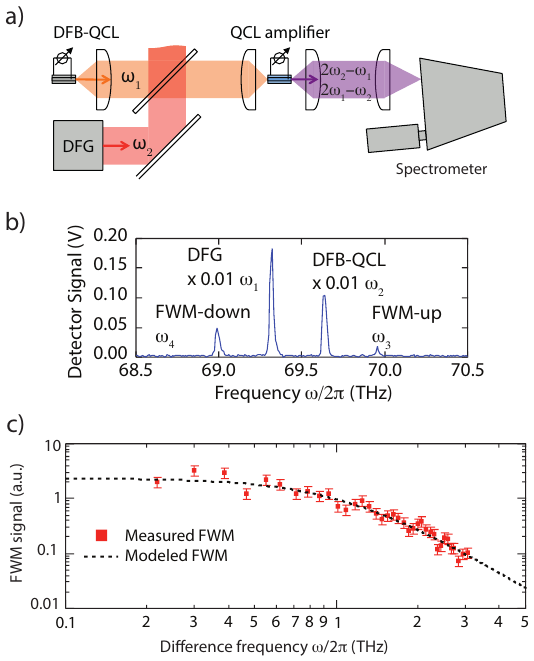
Figure 4: Four-wave mixing in a QCL active region. a Schematic dia- gram of the experimental setup. b Measured spectrum for a source separation δω = ω 2 − ω 1 of 314 GHz. c Response of the FWM pro- cess as a function of detuning between the two sources (points), compared with the predictions of a two-level model (dashed